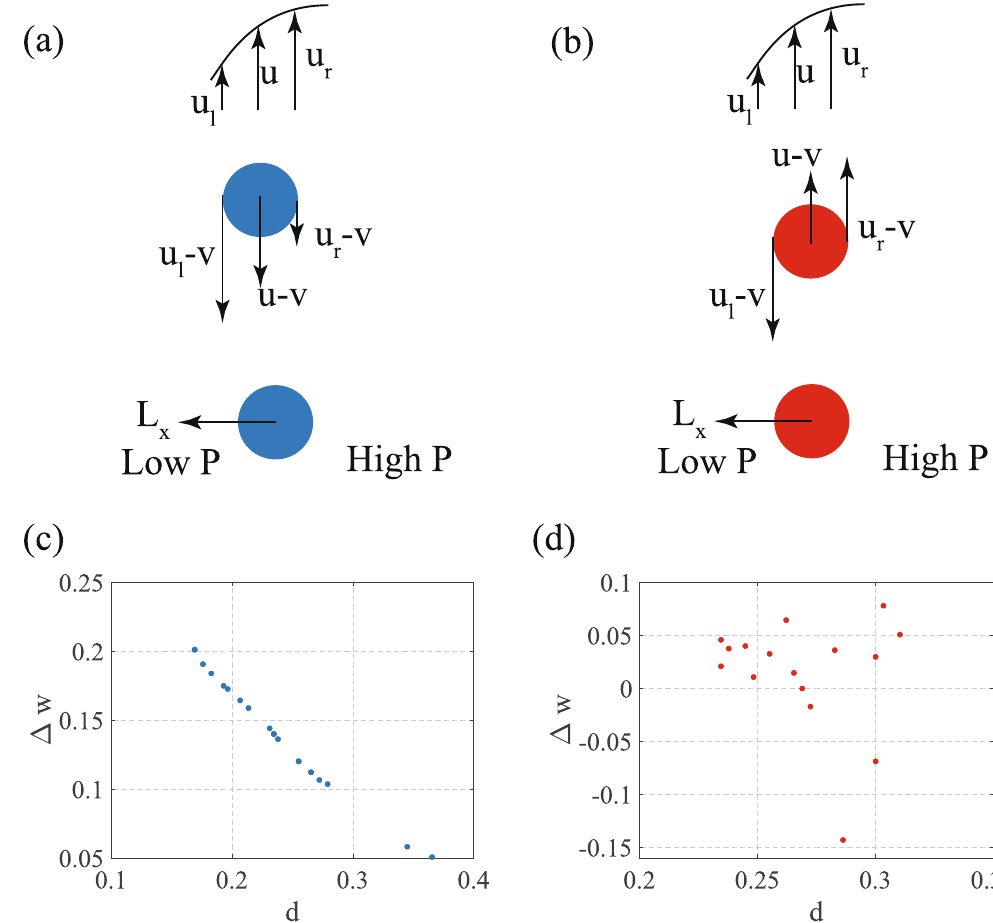
Figure 4. ( a and b ) A schematic of the axial velocity of the fluid and this velocity in a particle fixed frame of reference. The lower part of these figures showthe direction of the hydrodynamic lift force, L f on the particles. ( c and d ) the relative axial velocity of the fluid, Δ w , diametrically opposite ends of particles in both the focusing